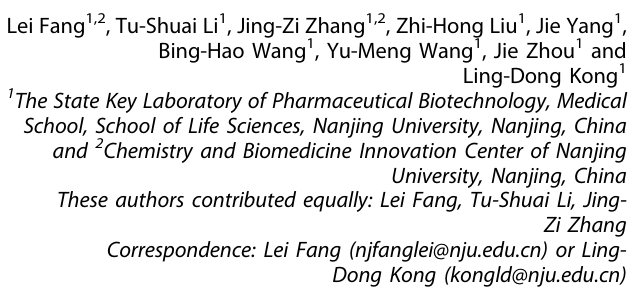
Fig. 1 High fructose drives mitochondrial metabolic reprogramming in podocytes via Hmgcs2-stimulated fatty acid degradation. a Quantitative proteomics revealed a continuously upregulated protein cluster causing mitochondria-related events in rat glomeruli during 16-week fructose modeling. b – d The mitochondria ultrastructure was severely disrupted in glomerular podocytes of high fructose-fed rats. b Representative images of mitochondria ultrastructure by transmission electron microscopy. The size and total number of mitochondria in glomerular podocytes of normal and model groups are shown in c , d , respectively ( n = 5 per group). e The mitochondria depolarization and ΔΨ m reduction were detected in 5 mM fructose-exposed differentiated podocytes ( n = 5 per group). f Mito stress test was performed to measure the key parameters of mitochondrial function in differentiated podocytes with or without 5 mM fructose exposure ( n = 10 per group). The quanti fi cation of OCR data in f , w , ab have been normalized by mitochondrial protein. g , h Ketogenesis was signi fi cantly upregulated in rat glomeruli starting from the eighth week of fructose modeling. Upregulation of ketogenesis was shown by both heatmap ( g ) and volcano plot ( h ). i Fatty acid degradation was signi fi cantly upregulated in rat glomeruli starting from the 12th week of fructose modeling. j Time-dependent increase of ketone body 3-HB in rat renal cortex during fructose modeling ( n = 4 per group). k HDACs activity was time-dependently inhibited in renal cortex of high fructose-fed rats ( n = 4 per group). l , m Knockdown of Hmgcs2 reversed upregulation of 3-HB induced by high fructose in differentiated podocytes ( l ) and in mouse glomeruli ( m ) ( n = 4 per group). n , o Knockdown of Hmgcs2 partially rescued the inhibited HDACs activity induced by high fructose in differentiated podocytes ( n ) and in mouse glomeruli ( o ) ( n = 4 per group). p , q Knockdown of Hmgcs2 reversed upregulation of H3ac and H4ac induced by high fructose in differentiated podocytes ( p ) and in mouse glomeruli ( q ) ( n = 6 per group). r , s The increasing levels of H3K9ac and H4K12ac at Eci1 or Eci2 promoter induced by high fructose were signi fi cantly reversed by knockdown of Hmgcs2 in differentiated podocytes ( r ) and mouse glomeruli ( s ). Enrichment of H3K9ac and H4K12ac at Eci1 or Eci2 promoter were measured by real-time qPCR and quantitated in differentiated podocytes or mouse glomeruli